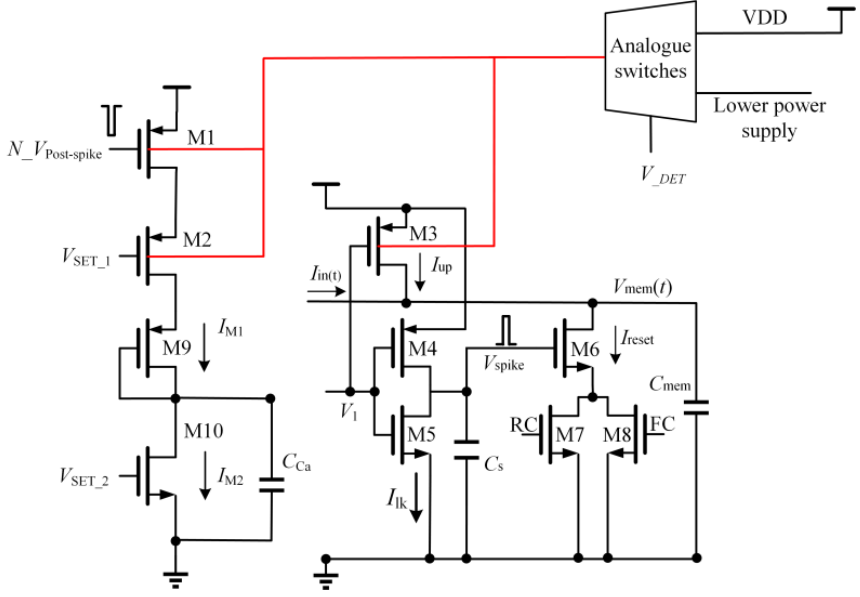
Figure 13. Radiation tolerance circuit for spike amplitude decay.